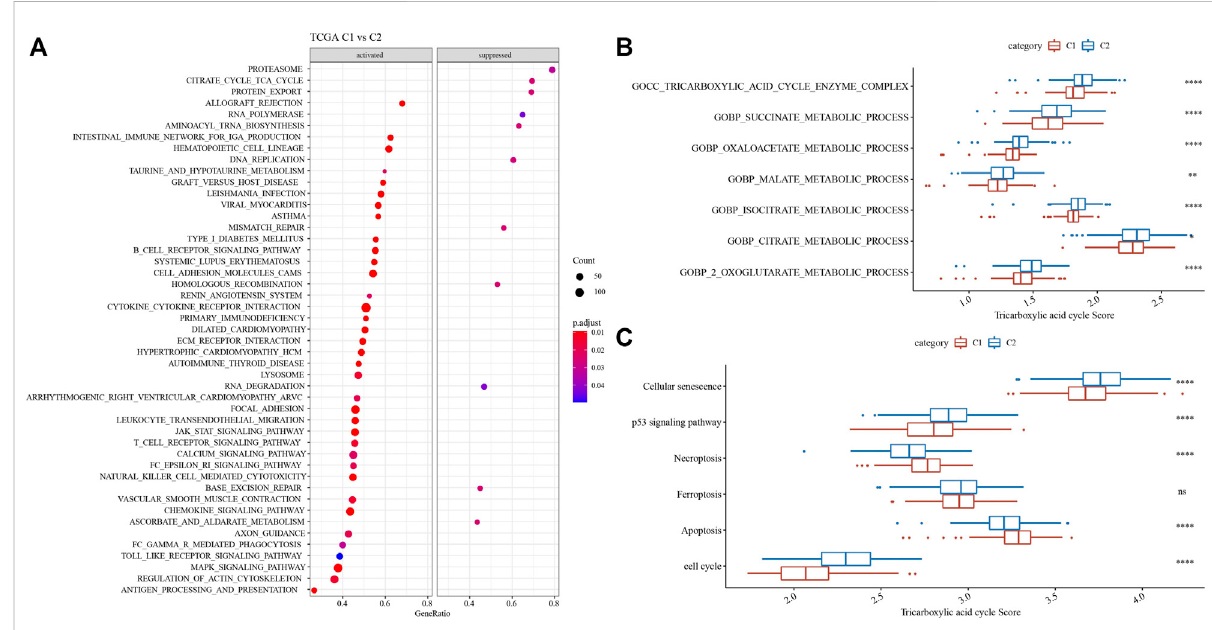
FIGURE 5 Functionalenrichmentanalysis. (A) GSEAanalysisdemonstratedthatpathways,suchas,cellcyclewereactivatedinC2. (B) 7TCApathwayswere activated in C2. (C) 6 pathways associated with tumorigenesis had differences in C1 and C2. * p < 0.05, ** p < 0.01, *** p < 0.0001, ns: no signi fi